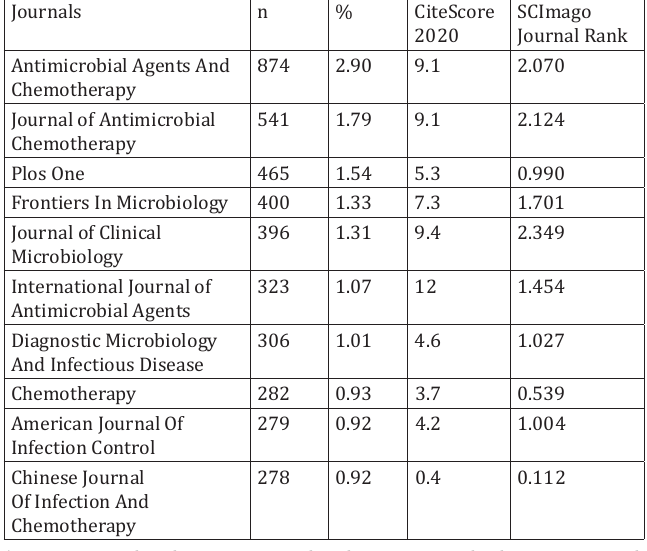
The list of top 15 institutions contributing the Acinetobacter literature (n=30074).